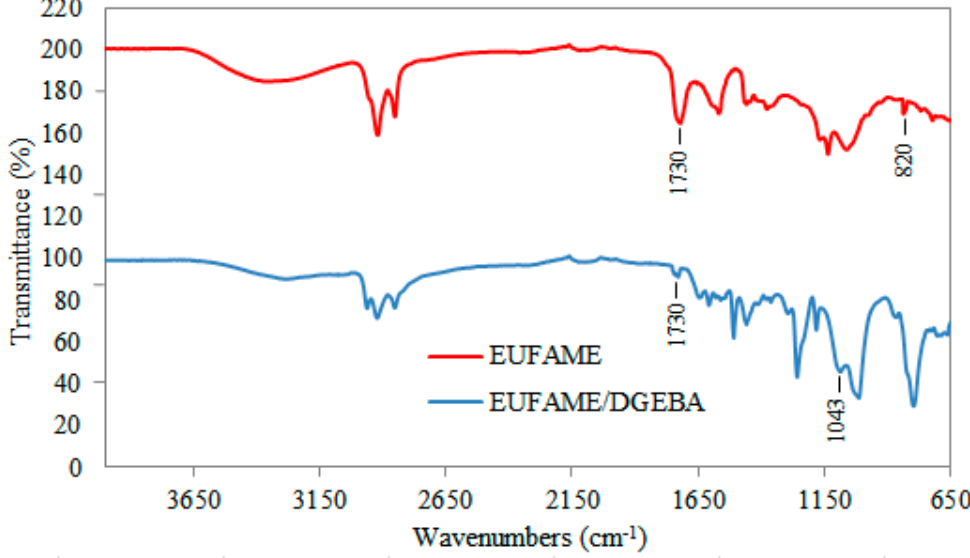
Figure 5. FT-IR spectra of uncured EUFAME and cured EUFAME/DGEBA. EUFAME: Unsaturated Fatty Acid Methyl Esters. EUFAME/DGEBA: Bio-based epoxy blend of EUFAME and DGEBA (neat epoxy resin).